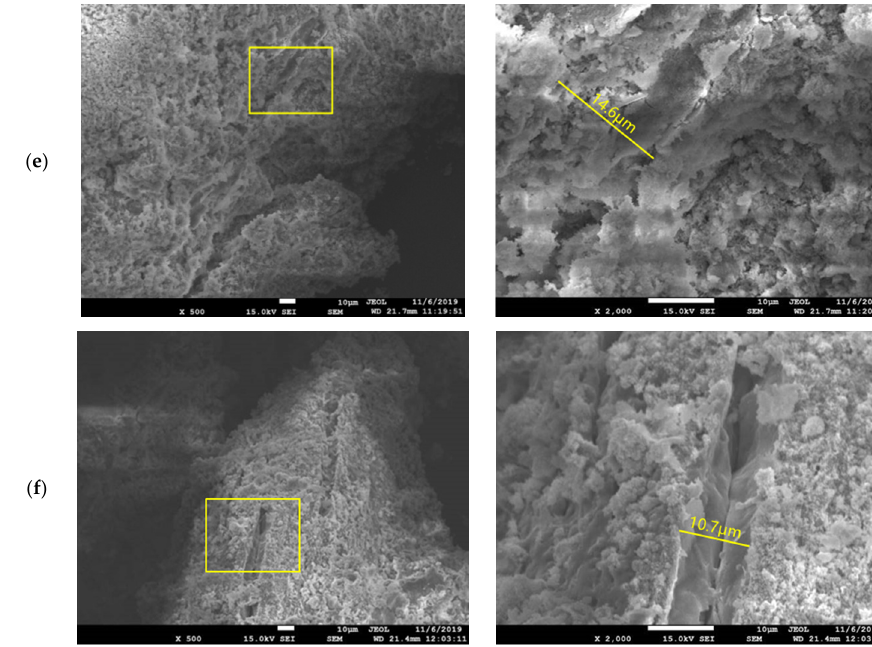
Figure 15. Morphologies of PVA-ECC after exposure to various temperatures: ( a ) 30 ℃ , ( b ) 200 ℃ , ( c ) 400 ℃ , ( d ) 600 ℃ , ( e ) 800 ℃ , ( f ) 1200 ℃.